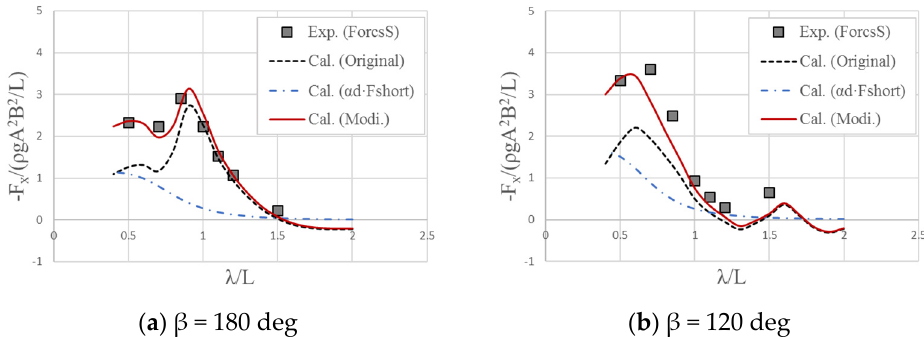
Figure 12. Modification of surge drift force on KVLCC2: V = 6 knots, H/L = 1/50.